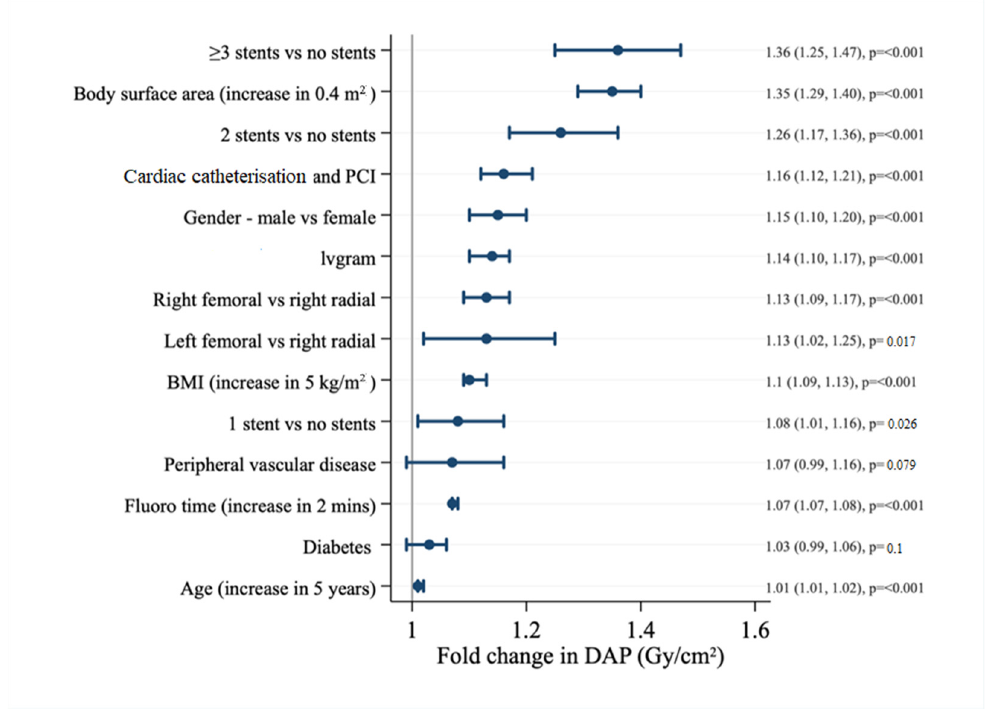
Figure 3. Multivariate analysis of PCI cohort. BMI, body mass index; DAP, dose area product; IVUS,